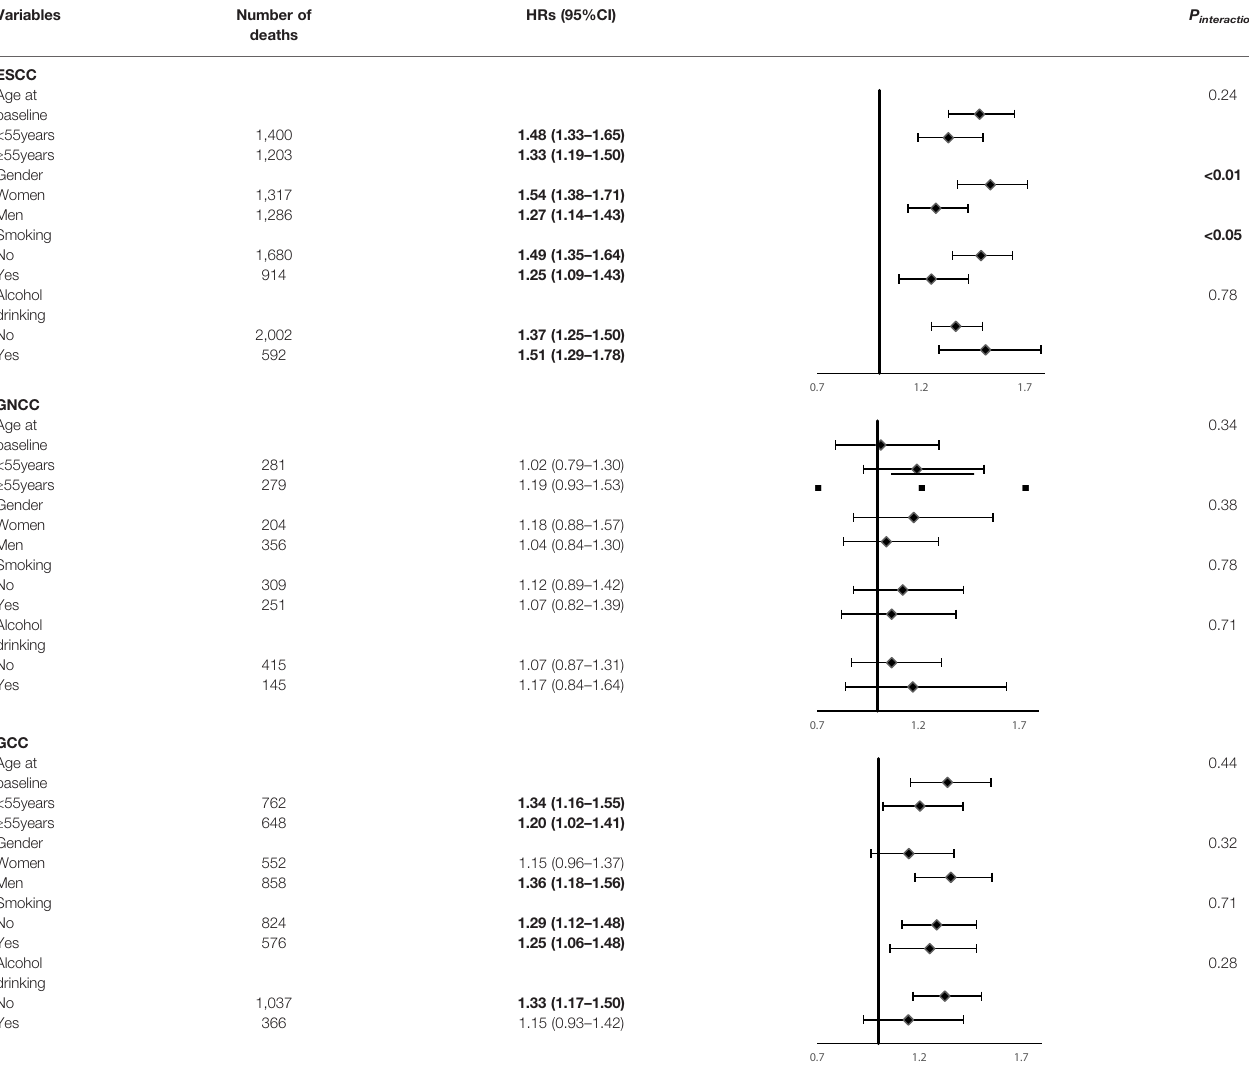
TABLE 5 | Subgroup analyses for family history of UGI cancer and risk of ESCC, GCC and GNCC mortality Variables